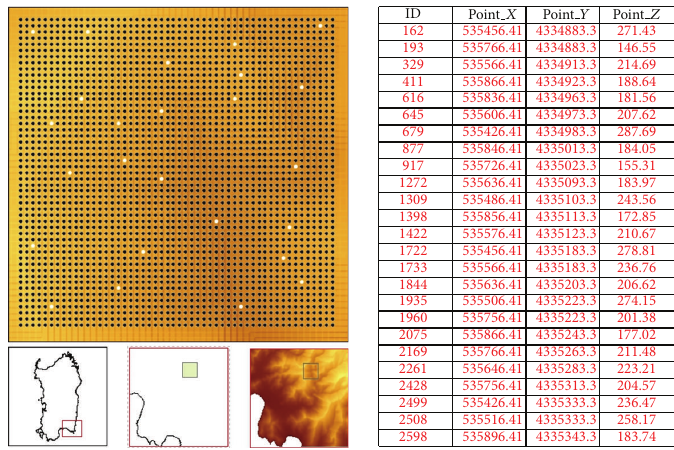
Figure 20: On the left, the localization of the test grid is shown; on the right, the 25 test point 𝑋 , 𝑌 , and 𝑍 is shown.